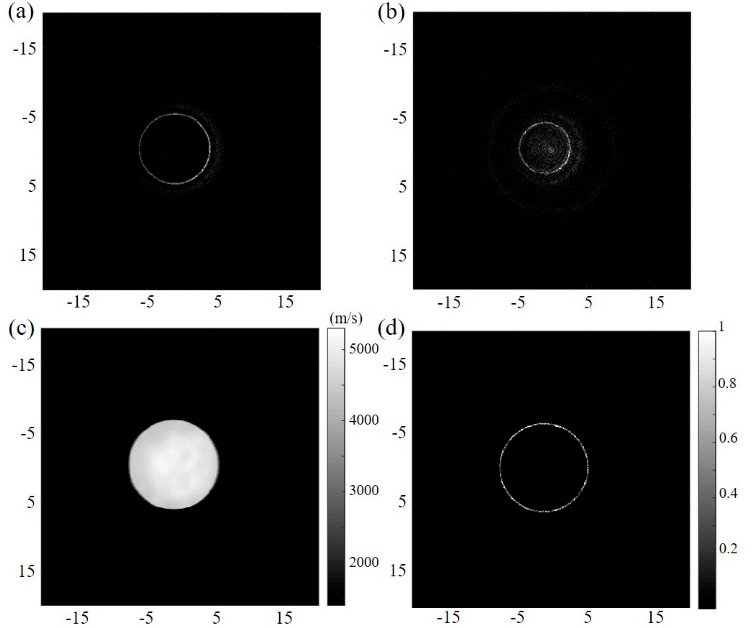
Figure 5. Phantom experimental results. The reflection image from the constant acoustic speed ( a ) 1490 m/s and ( b ) 1540 m/s. ( c ) SoS map derived from the transmission USCT. ( d ) SoS adaptive reflection image in USCT.